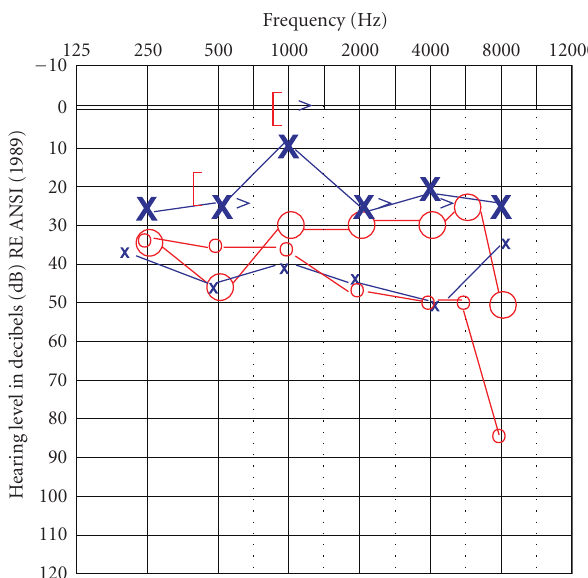
Figure 3: Bilateral pure tone audiogram post steroid infusion. Small X’s and O’s indicate pretreatment